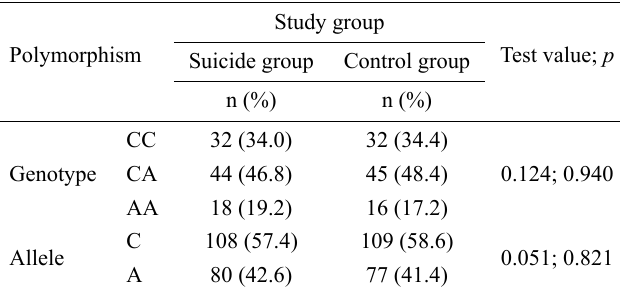
Table 4. Comparison of study groups in terms of TPH-1 gene rs1800532 polymorphism.